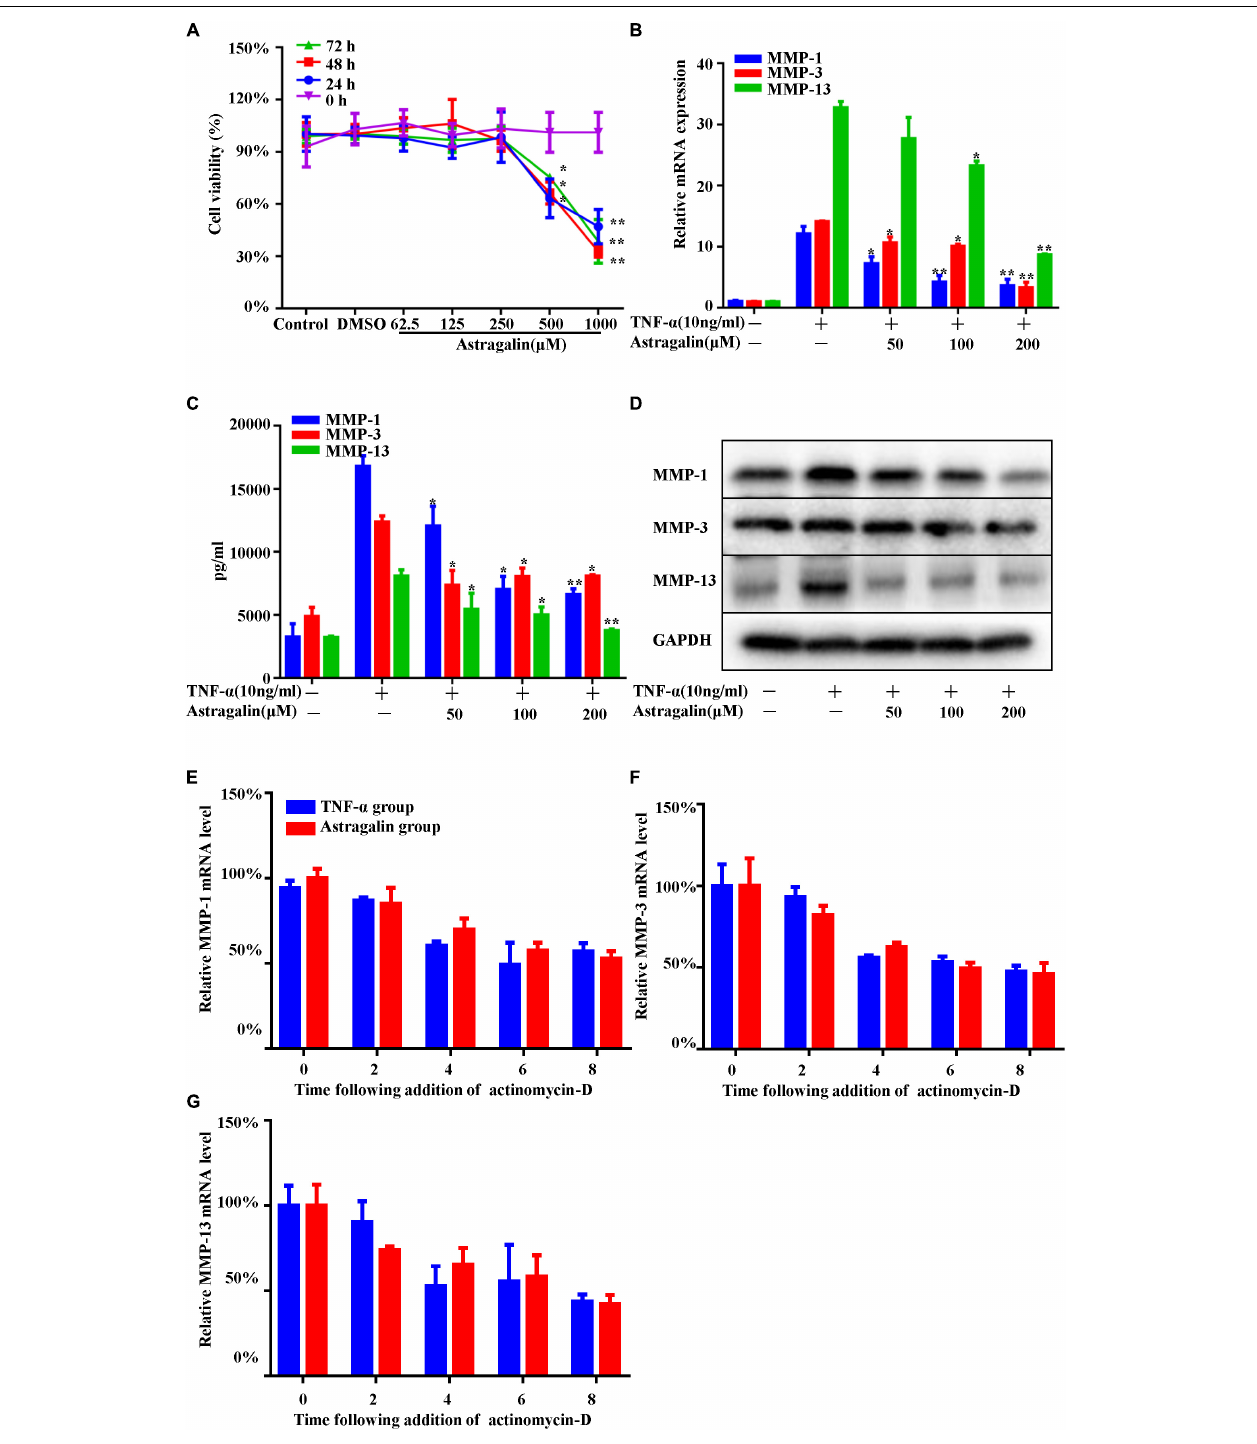
FIGURE 5 | Astragalin suppressed the mRNA and protein expression of MMPs in TNF- α -induced MH7A cells. MH7A cells were treated with different concentrations of astragalin for 0, 24, 48, and 72 h, and cell viability was measured by CCK-8 assay (A) . MH7A cells pretreated for 2 h with various concentrations of astragalin (0, 50, 100, 200 µ M), and then exposure to TNF- α (10 ng/ml) for 24 h, the mRNA and protein levels of MMP-1, MMP-3, and MMP-13 were determined using the RT-PCR, ELISA assay, and western blot analysis (B–D) . MH7A cells were pretreated with astragalin (200 µ M) or not for 2 h, then stimulated with TNF- α for 6 h. Actinomycin D (4 µ g/mL) was added to the cells and then mRNA was isolated at time point 0, 2, 4, 6, and 8 h. The levels of MMPs mRNA stability were detected by RT-PCR (E–G) . Data are shown as mean ± SEM of three independent experiments. ∗ p < 0.05, ∗∗ p < 0.01 compared with TNF- α stimulation alone.